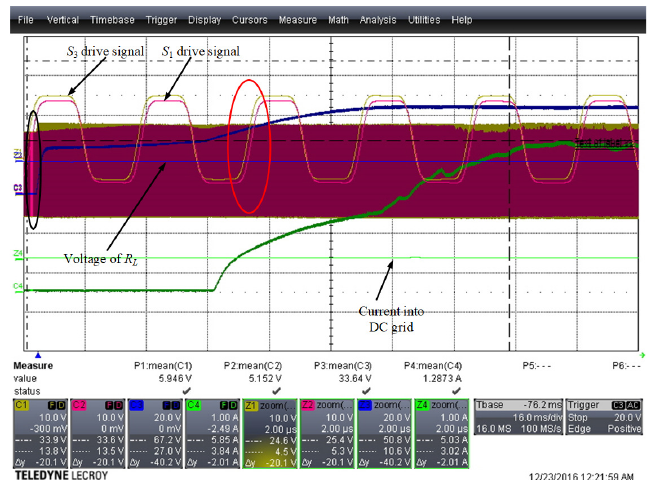
Figure 26. Original waveform of reverse transfer.